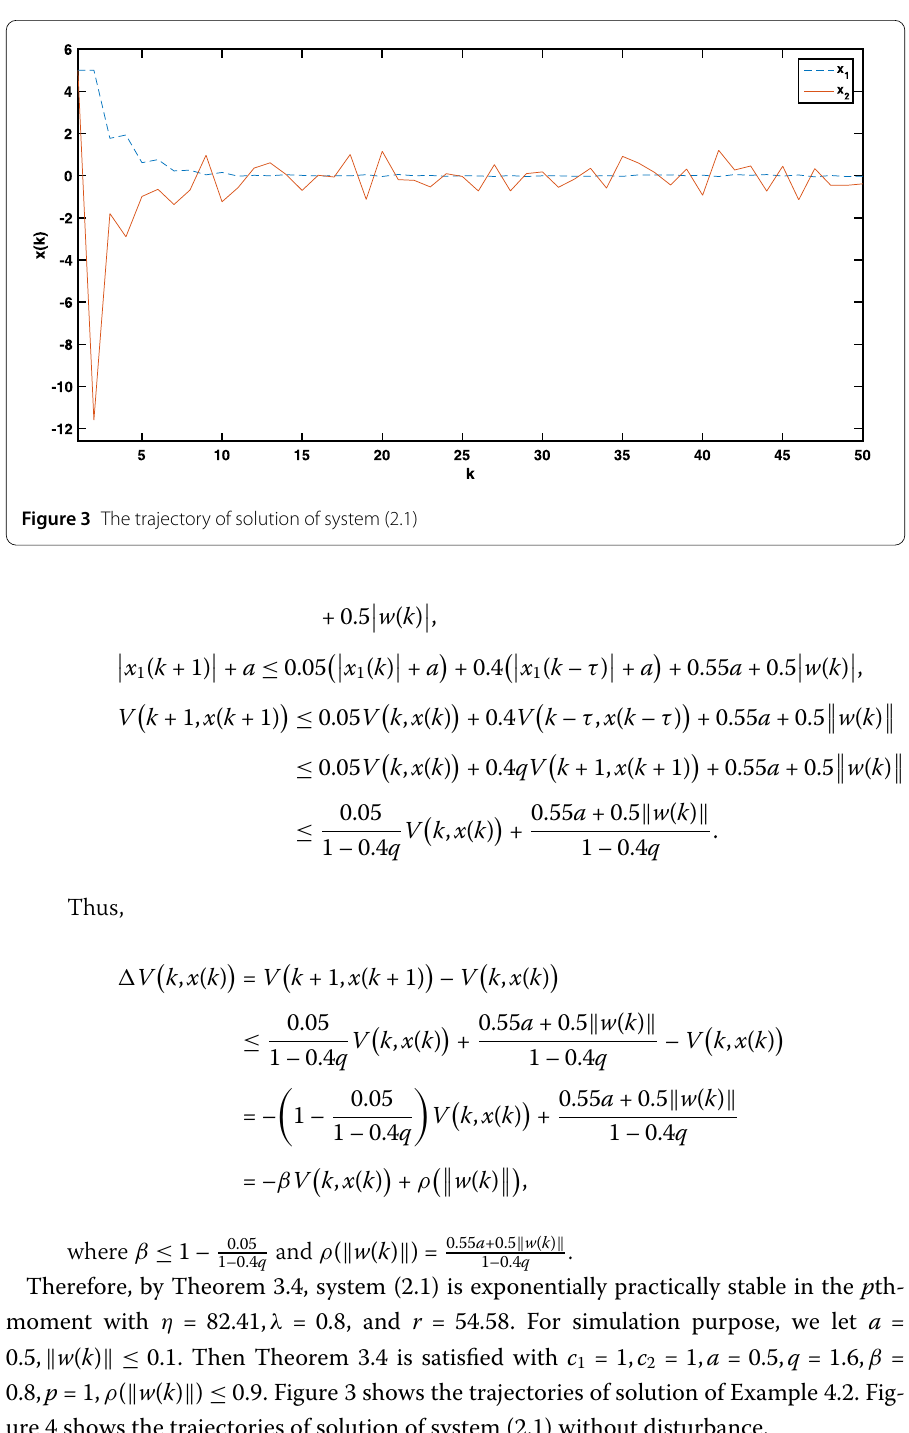
Figure 3 The trajectory of solution of system (2.1)